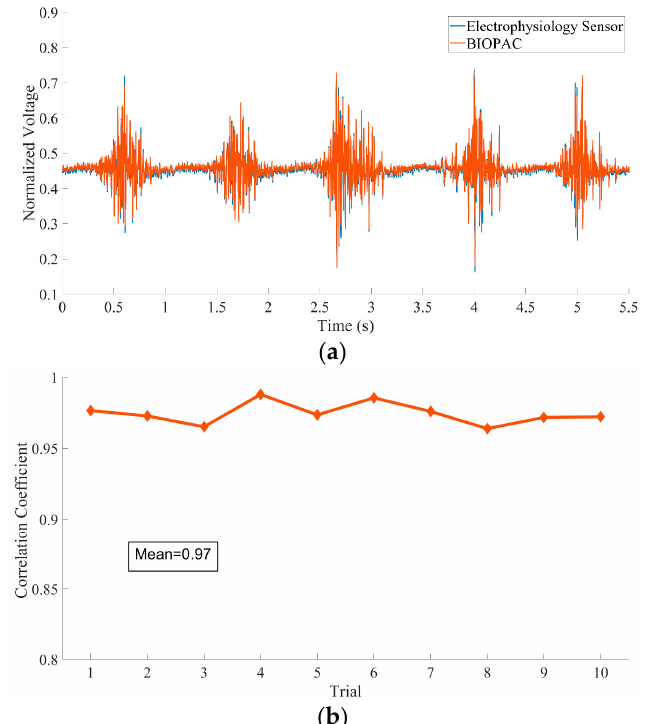
Figure 10. ( a ) A comparison of 11-s EMG signals acquired by the electrophysiology sensor and BIOPAC EMG module. ( b ) Correlation coefficient between the EMG recorded from the two sensors. Recordings from the two sensors show a remarkably high correlation.